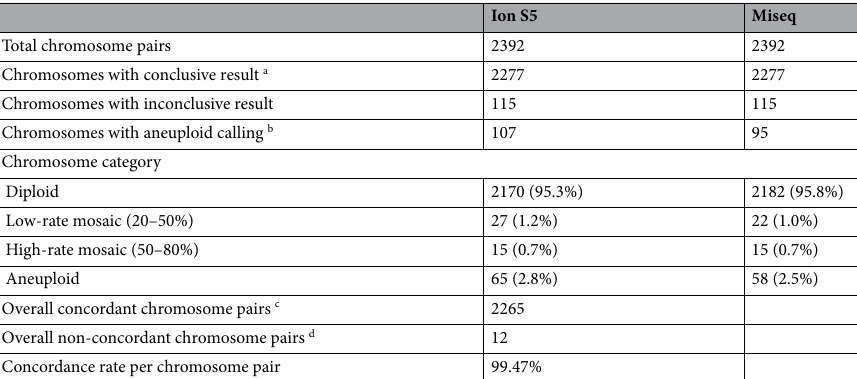
Table 3. Concordance analysis per chromosome pair. a It excludes embryos with chaotic mosaicism, in which the individual chromosomes affected could not be distinguished. b It includes individual chromosome pairs with mosaicism or aneuploidy. c Chromosome pairs identified as diploid or mosaic/aneuploid on the both two NGS systems. Mosaic/aneuploid chromosome pairs with different aneuploid percentages on each system are also included. d Chromosome pairs identified as diploid on the only one system, and as mosaic/aneuploid on the other